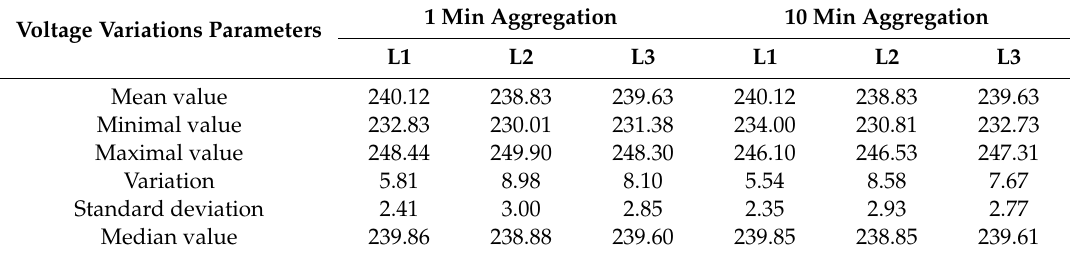
Table 3. Comparison of voltage variation parameters of 1 min and 10 min aggregation intervals.